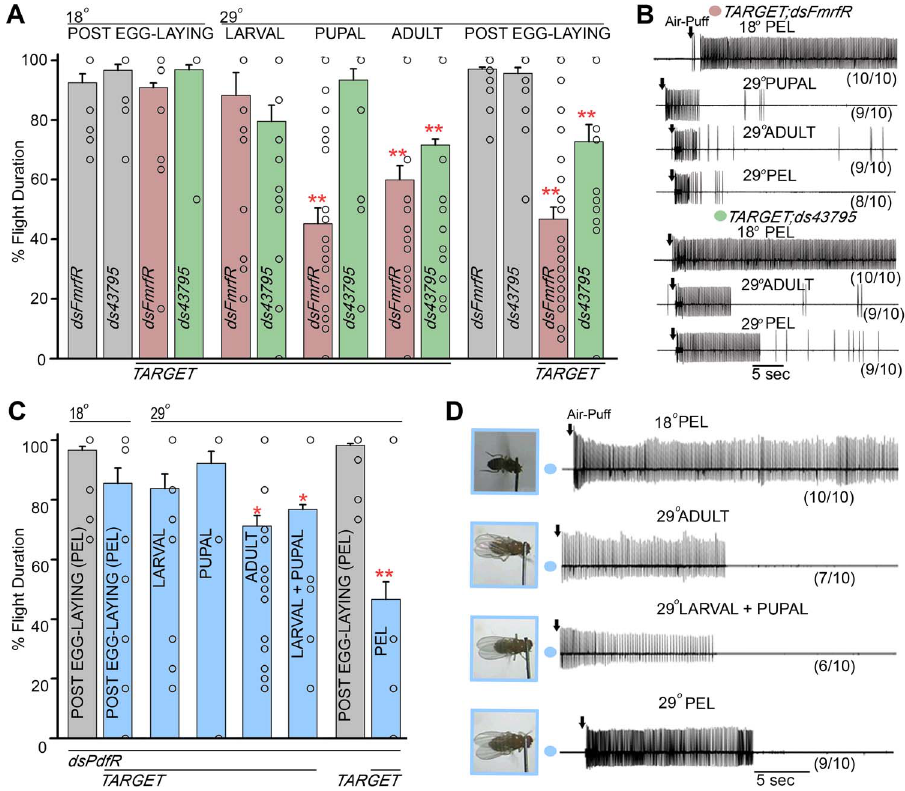
Figure 6. RNAi mediated knockdown of specific GPCRs during development and in adults result in flight deficits. A ) Percentage flight times of GPCR RNAi heterozygotes (grey) and pan-neuronal knockdowns of RNAi strains ( dsFmrfR in red, ds43795 in green) were obtained after knockdown from specific developmental stages as indicated above the bars. Open circles within the bars represent percentage flight times for individual flies. Mean flight times ( 6 SEM) were obtained by measuring tethered flight in three batches of 10 tethered flies of each genotype after an air-puff stimulus. Pupal and adult knockdowns at 29 u C were compared with the specific RNAi control at 18 u C; post egg-laying (PEL) knockdowns were compared with their specific RNAi controls at 29 u C (**P , 0.01, *P , 0.05; one-way ANOVA). B ) Electrophysiological recordings from the DLMs of air- puff stimulated tethered flies of the indicated genotypes. The temporal stages at which knockdowns were initiated are indicated above each trace. Also shown below each trace is the number of flies that showed the given response upon the number of flies tested. In each case the remaining flies showed normal firing responses. All control flies at 18 u C showed rhythmic firing throughout flight. C ) Percentage flight time (mean 6 SEM) of flies with pan-neuronal knockdown of the PdfR . Knockdown was initiated from different developmental stages at 29 u C as indicated. Open circles within the bars show percentage flight times for each fly. Pan-neuronal knockdown of the PdfR , either in adults or during development (larval + pupal), results in significant flight deficits (*P , 0.05, as compared to 18 u C PdfR knockdown control, by one way ANOVA). Strongest flight deficits are observed upon PdfR knockdown throughout development by shifting to 29 u C post egg-laying (PEL; **P , 0.01, when compared to RNAi heterozygotes at 29 u C post egg-laying). D ) Snapshots of single flight assay video recordings and electrophysiological recordings from DLMs of animals with pan-neuronal knockdown of the PdfR at the indicated temperatures and developmental stages. The number of flies that showed the given response upon the number of flies tested is shown below each trace. The remaining animals showed normal flight and firing responses as seen in the 18 u C PEL control on top.